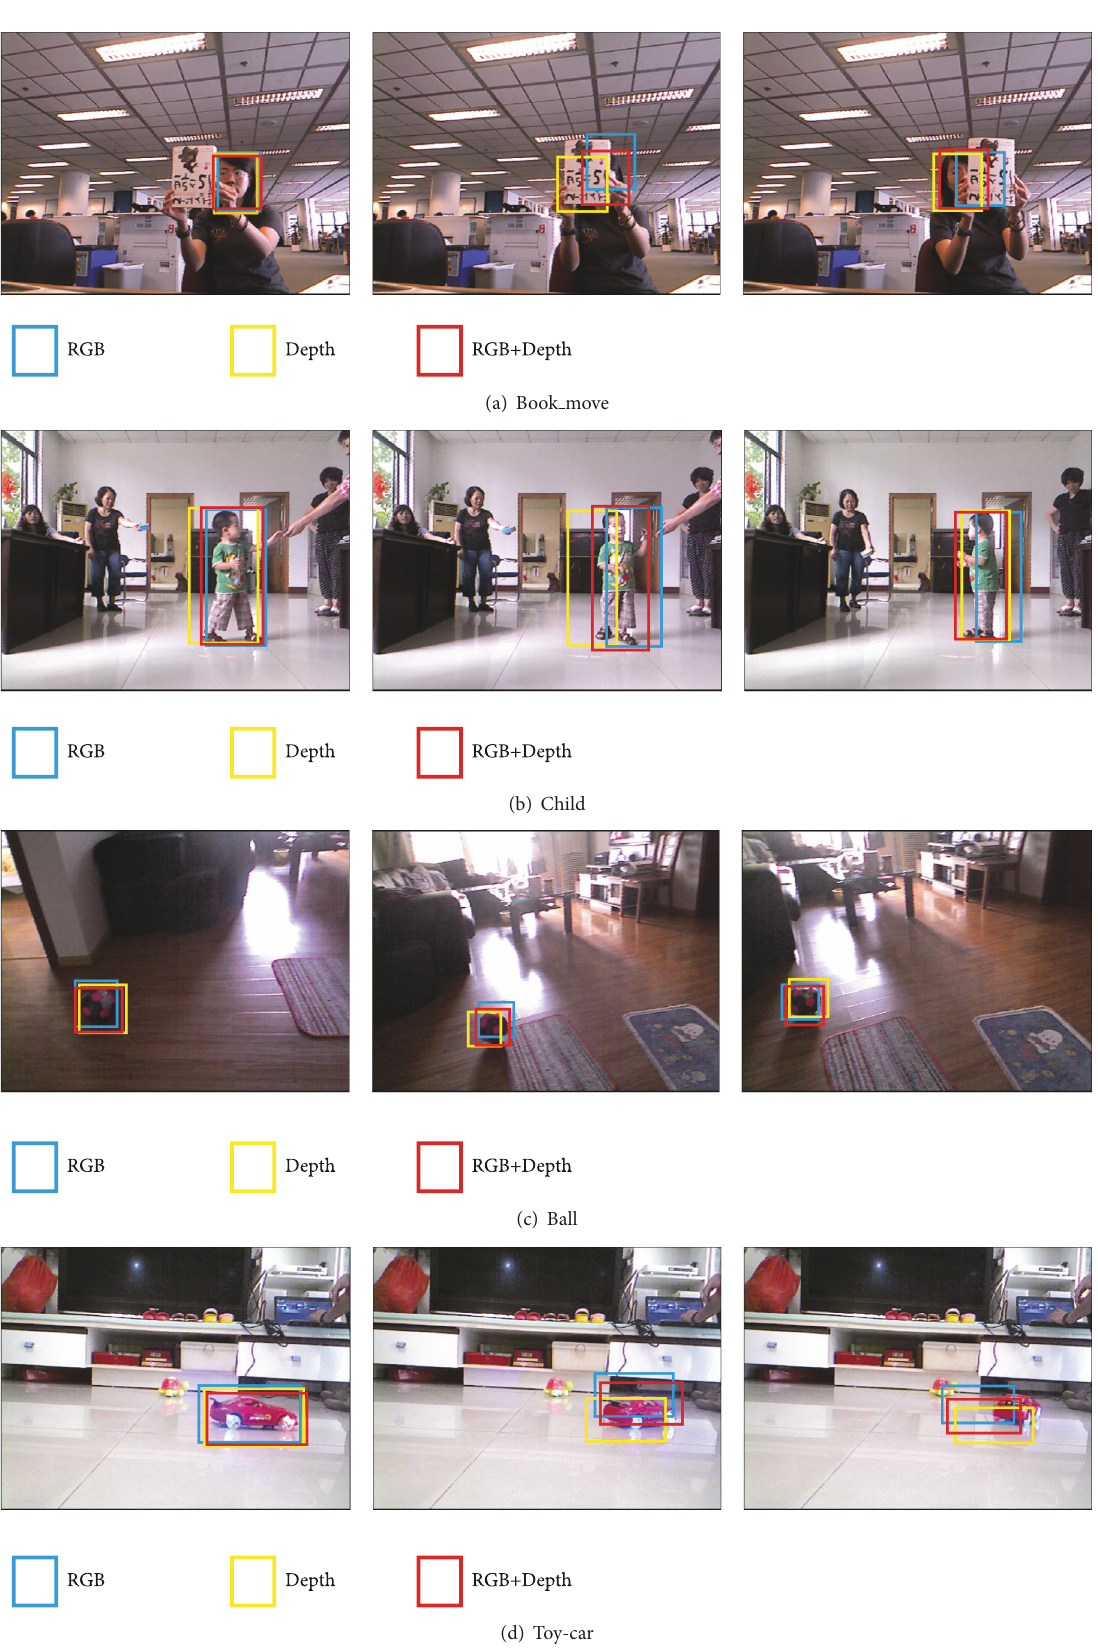
Figure 4: The tracking results of the selected test